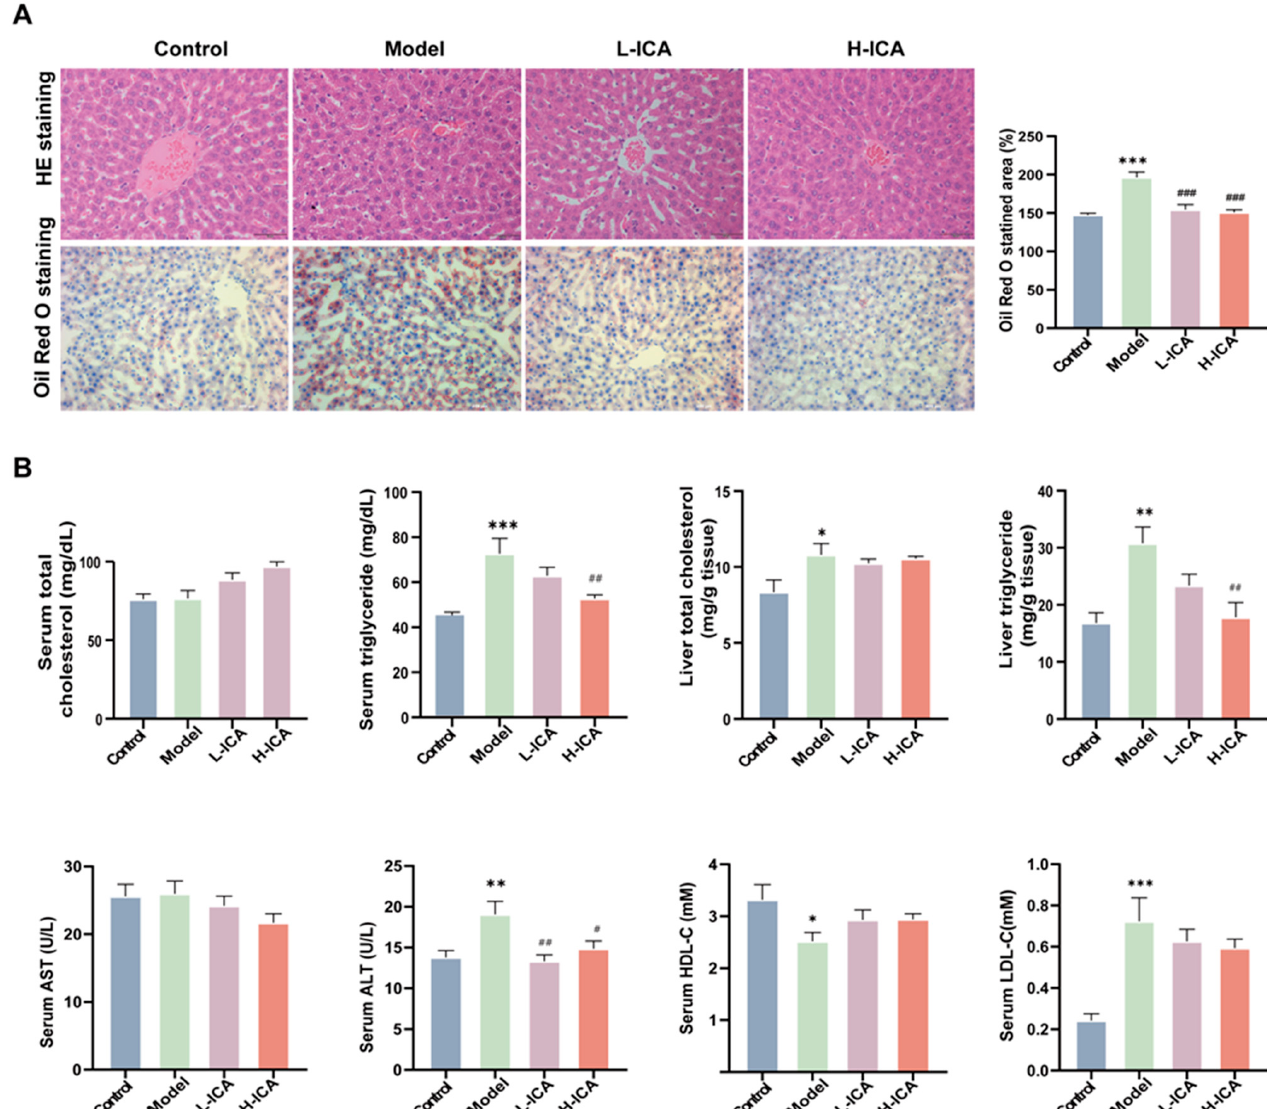
Figure 2. Icariin improves liver steatosis and liver function in rats. The liver sections of rats were stained with hematoxylin and eosin (scale bar = 50 µ m) and Oil red O (scale bar = 200 µ m) ( A ). Serum specimens were collected for TC, TG, AST, ALT, HDL-C, and LDL-C; liver samples were collected for TC and TG ( B ). n = 6, values are mean ± SEM; Control vs. Model, * p < 0.05, ** p < 0.01, *** p < 0.001; Model vs. drug group # p < 0.05, ## p < 0.01, ### p < 0.001.